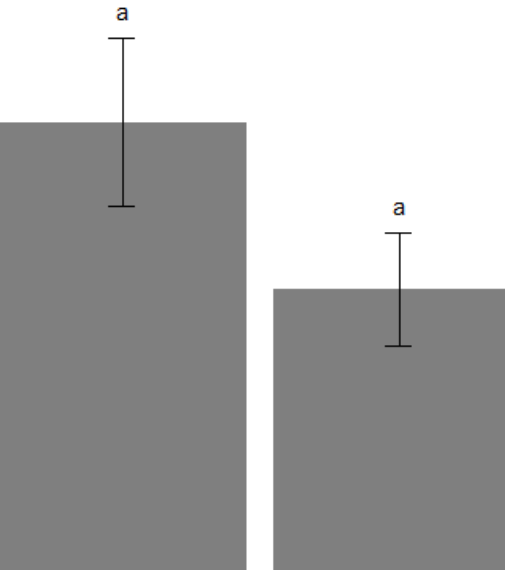
Figure 2. Seasonal variation of the tarnished plant bug population on mullein plants during 2016 and 2017.